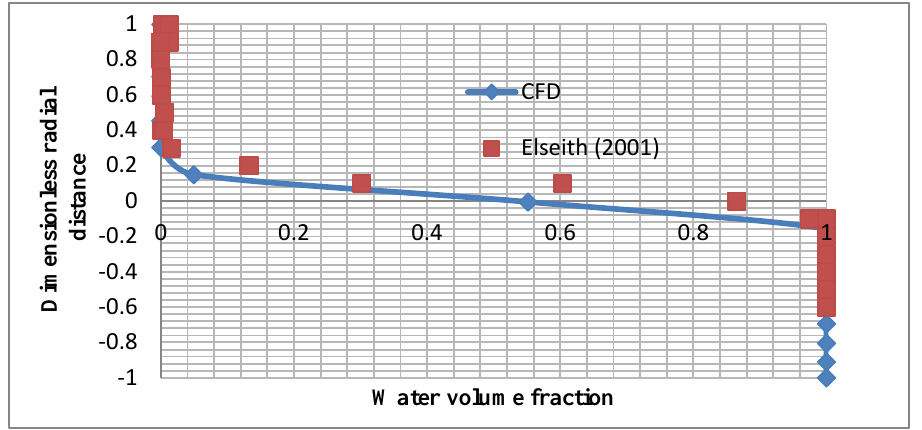
Figure 4. Comparison of radial variation of water volume fraction of computational work with